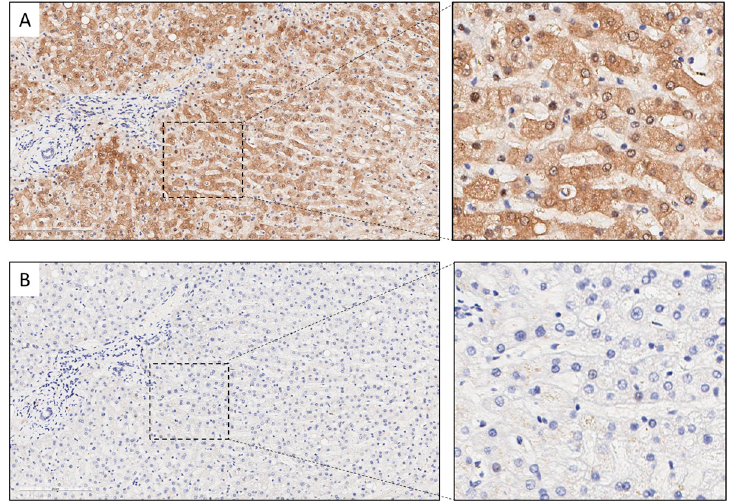
Figure A5. Microphotographs of immunohistochemistry staining of non-neoplastic liver control using KYNU antibody which shows positive cytoplasmic expression in hepatocytes ( A ), and diluent which displays negative expression of KYNU ( B ).